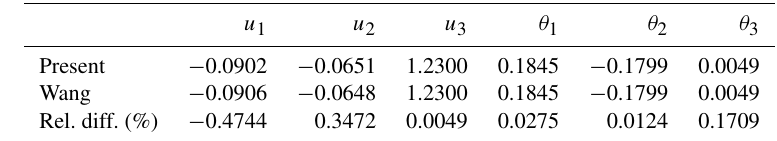
turbulence, tower shadow, and gravity) of a bend–twist to feather coupled blade for the DTU 10 MW RWT. The blade was coupled with a constant coefficient of γ y = − 0 . 2 along the blade. For the comparison, only the cross-sectional prop- erties of the blade were modified. The twist distribution and pitch angle were adopted from the reference turbine which explains the unusual shape of the power curve. The first 10 natural frequencies are compared in Table 4 and the results show only minimal differences. The power and thrust over the operational wind speed range are compared in Fig. 2 and, again, the results show only minimal